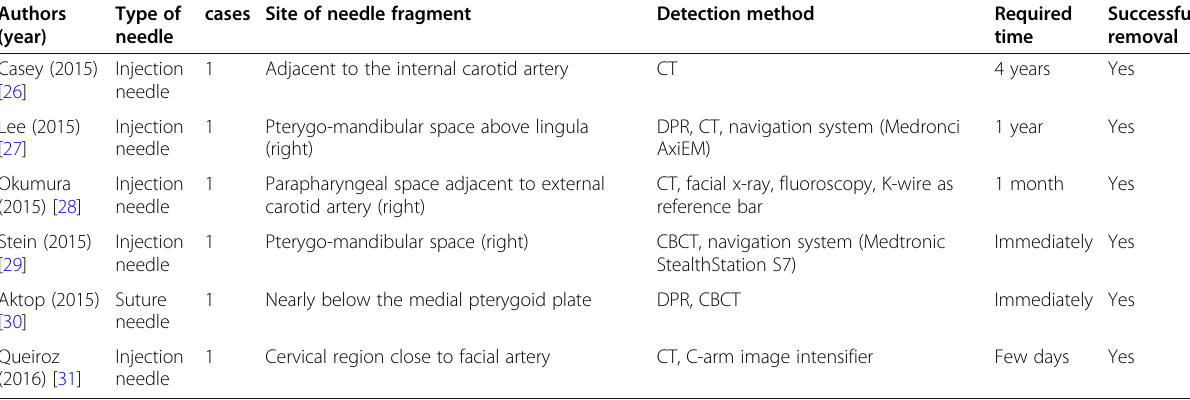
Table 1 Recent cases of needle removal